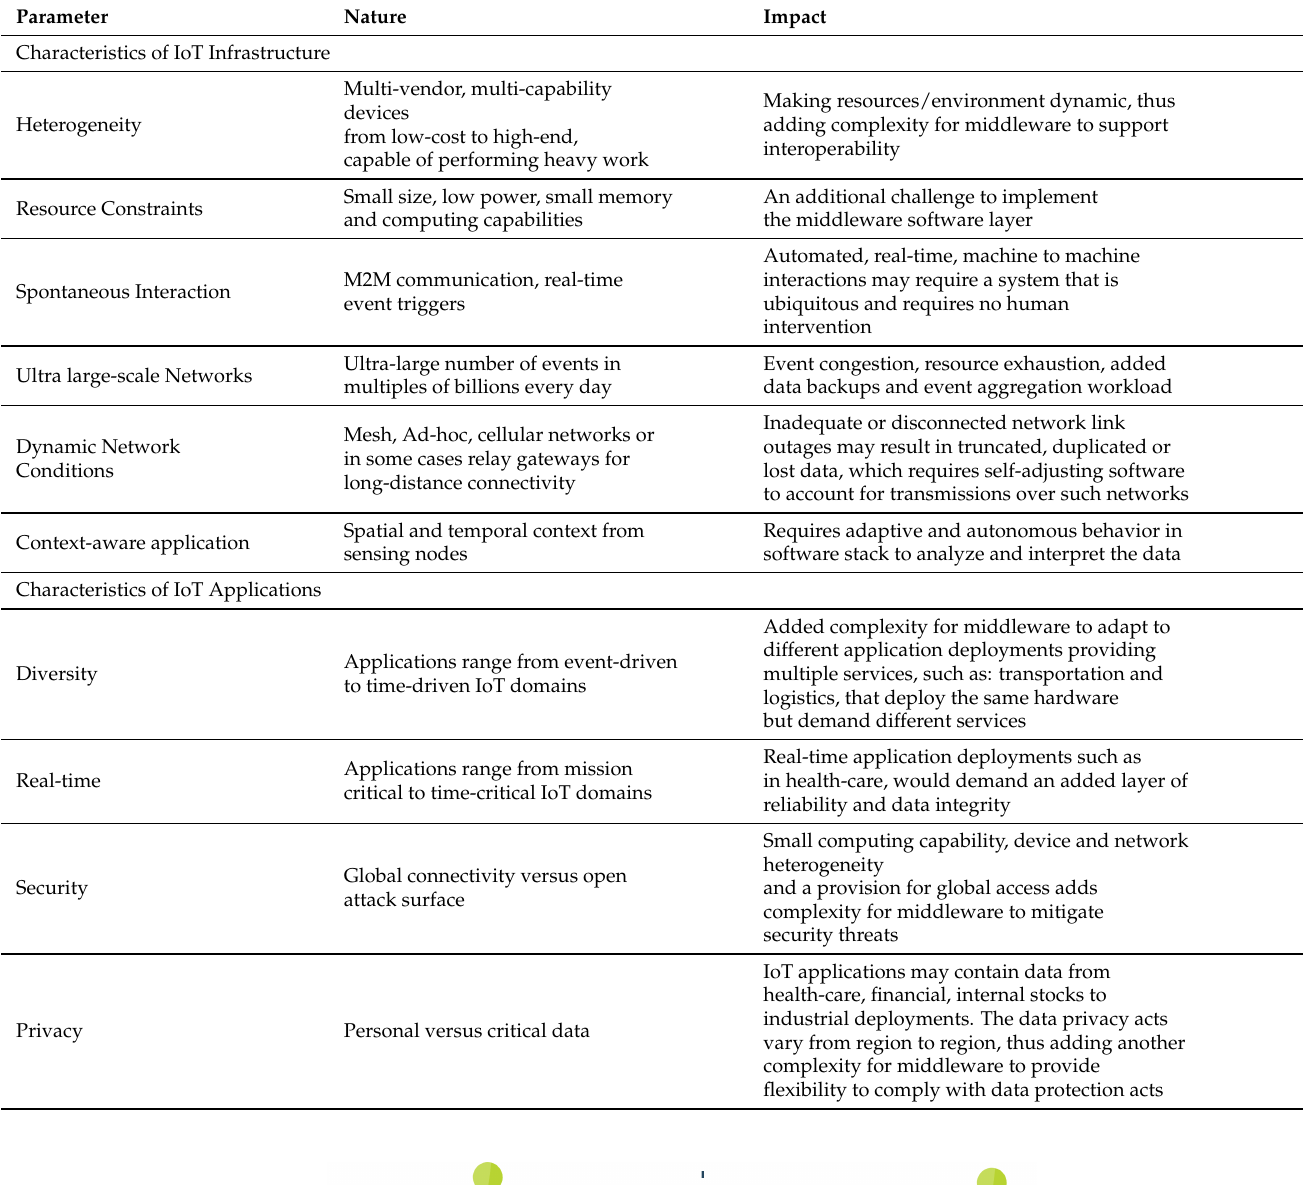
Table 7. IoT infrastructure and application characteristics.